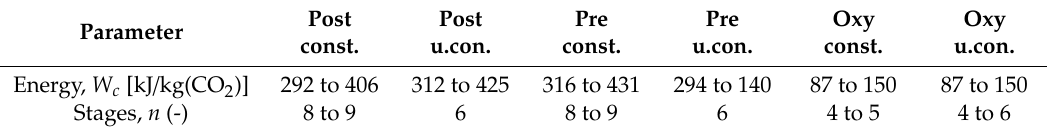
Post Post Pre Pre Oxy Oxy Post Post Pre Pre Oxy const. u.con. const. u.con. const. u.con. const. u.con. const. u.con. u.con.